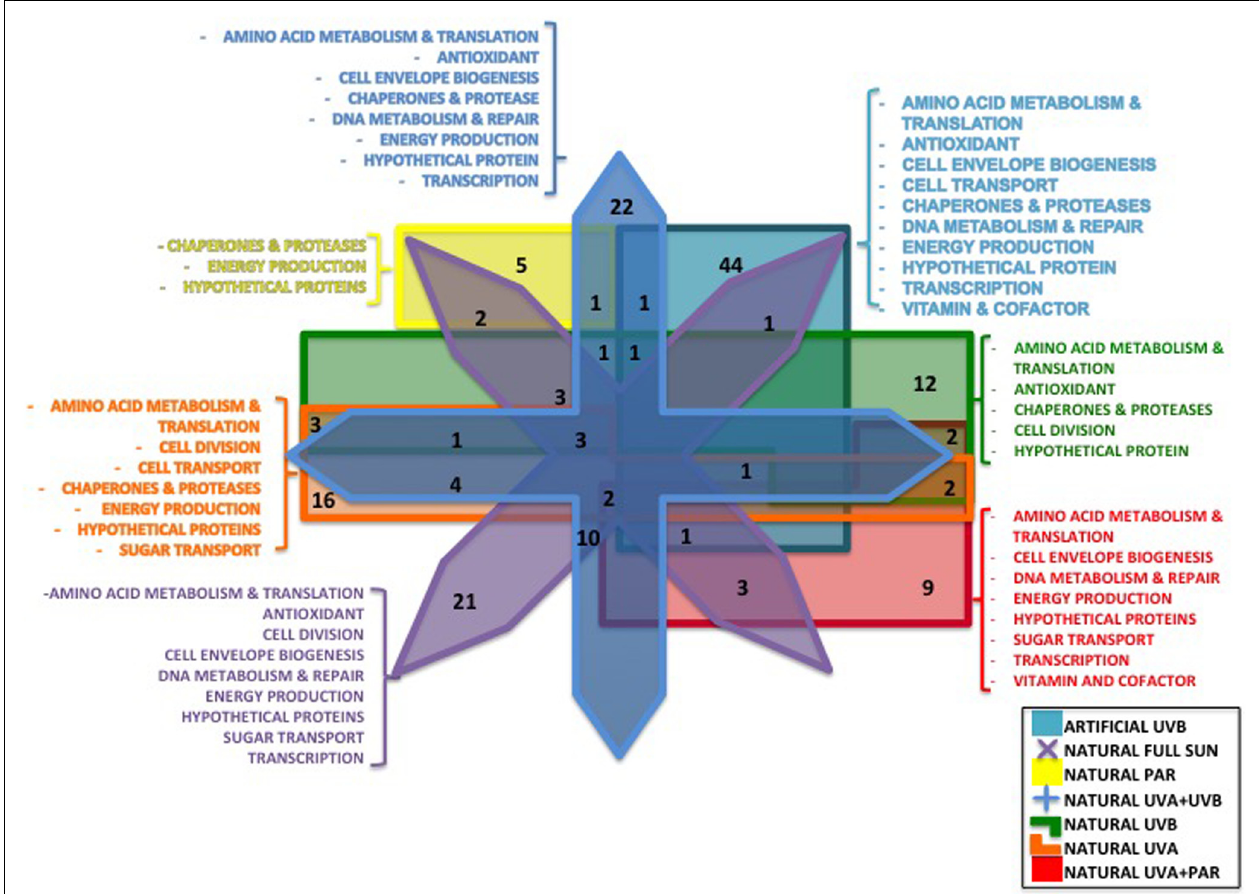
FIGURE 2 | Venn diagram showing the number of differentially regulated proteins characterized in the different conditions: Artificial UVB (49 proteins), Natural Full Sun (48 proteins), Natural PAR (8 proteins), Natural PAR+UVA (19 proteins), Natural UVA+UVB (47 proteins), Natural UVB (27 proteins), and Natural UVA (29 proteins). Functional categories of the quantified proteins characterized in only one condition were